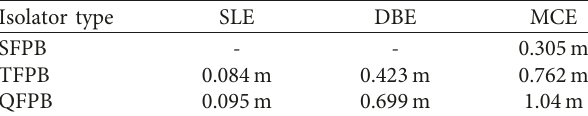
Table 4: PBD levels of friction pendulum